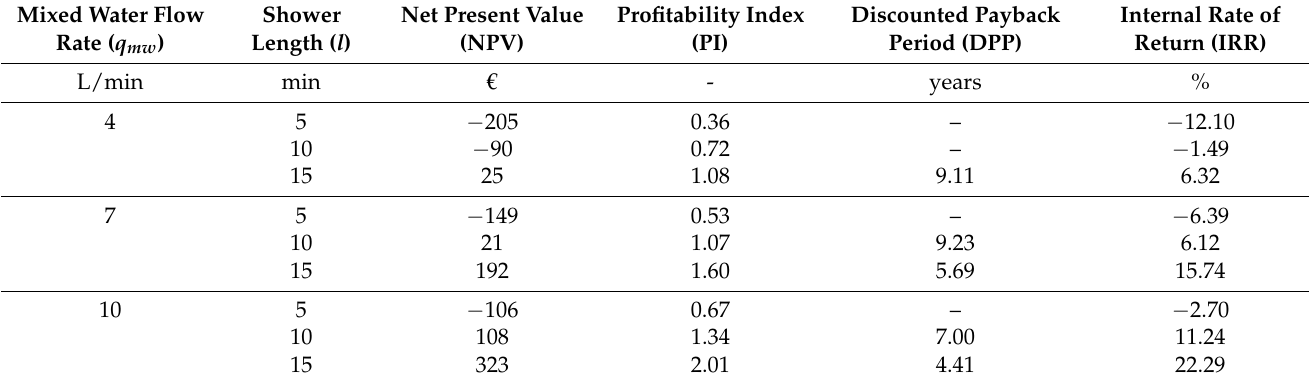
Table 5. Summary of the calculation results for a gas water